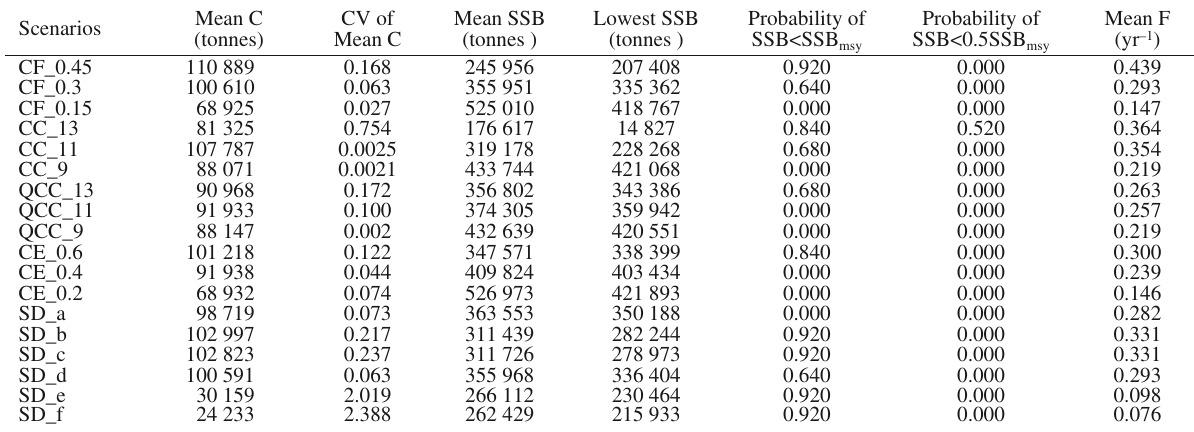
Table 3. – Performance measures derived from 250 simulation runs for a simulated bigeye tuna fishery managed with different management strategy scenarios for 25 years of simulation duration. The scenarios are defined in Table 2. Means are average (over simulation) annual values for projection years. (CF, constant fishing mortality; CC, constant catch; QCC, quasi-constant catch; CE, constant escapement; SD, status-dependent rule)